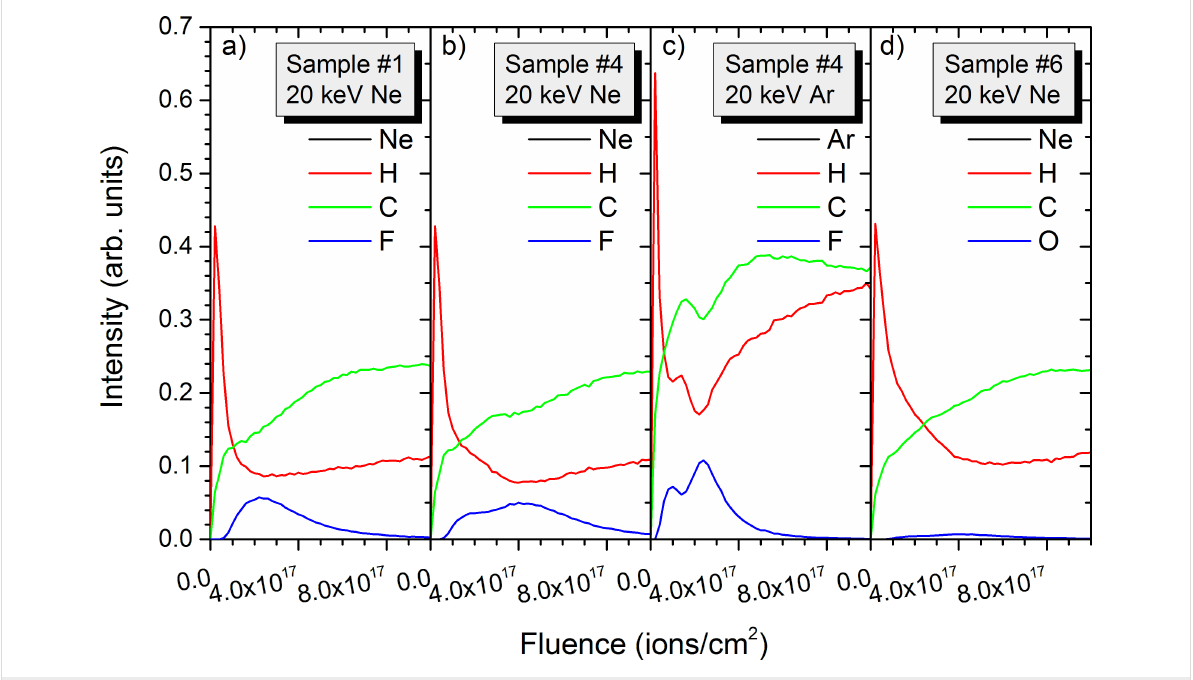
Figure 6: Simulated depth profiles for a) 20 keV Ne + irradiation of sample #1 with 10 nm and 20 nm inter-layer spacing, b) 20 keV Ne + irradiation of sample #4 with 20 nm and 40 nm inter-layer spacing, c) 20 keV Ar + irradiation of sample #4 with 20 nm and 40 nm inter-layer spacing, and d) 20 keV Ne + irradiation of sample #6 with 20 nm and 40 nm inter-layer